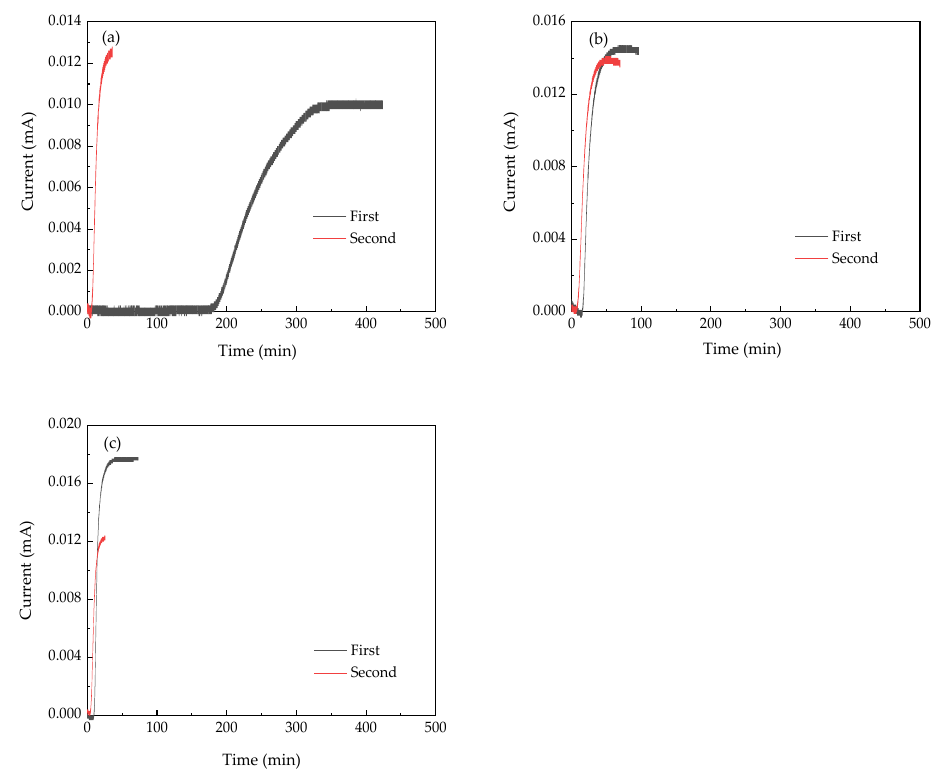
Figure 4. Current–time curves of hydrogen permeation test: ( a ) HR sample; ( b ) EF1 sample; ( c ) EF2 sample. Table 3. Hydrogen permeation parameters of HR, EF1, and EF2 samples.